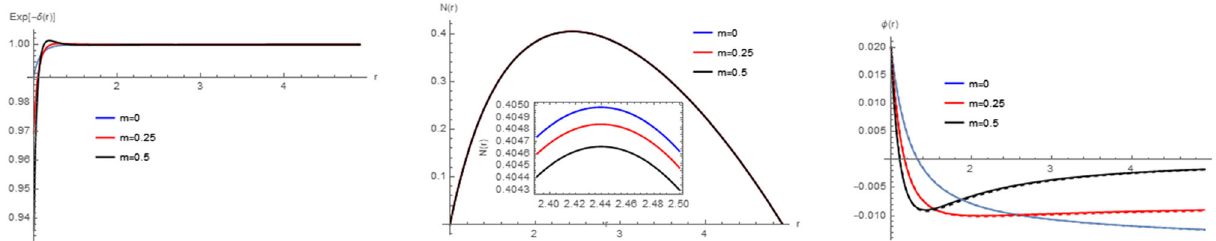
Fig. 15 Profile functions for typical scalarized solutions with different scalar masses. Here we have set (cid:2) = 0 . 1 and φ( r e ) = 0 . 02. In the right plot, the solid curves denote the profile for the scalar field after scalarization while the dashed curves denote the corresponding scalar clouds